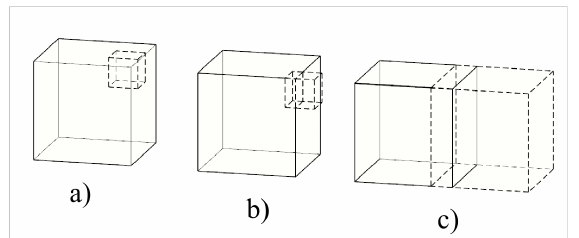
Figure 1. Solid/Solid Overlap: a) A’s edges are disjoint from B’s and a vertex of B is covered by A; b) A and B have faces that touch and a vertex of B is covered by A ; c) A and B have faces that touch and B has a face covered by A.